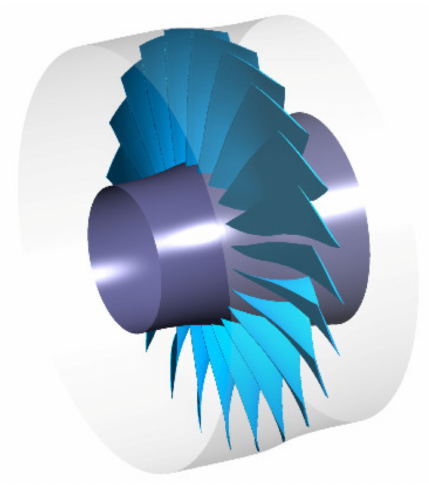
Figure 5. NASA Rotor 67 model.